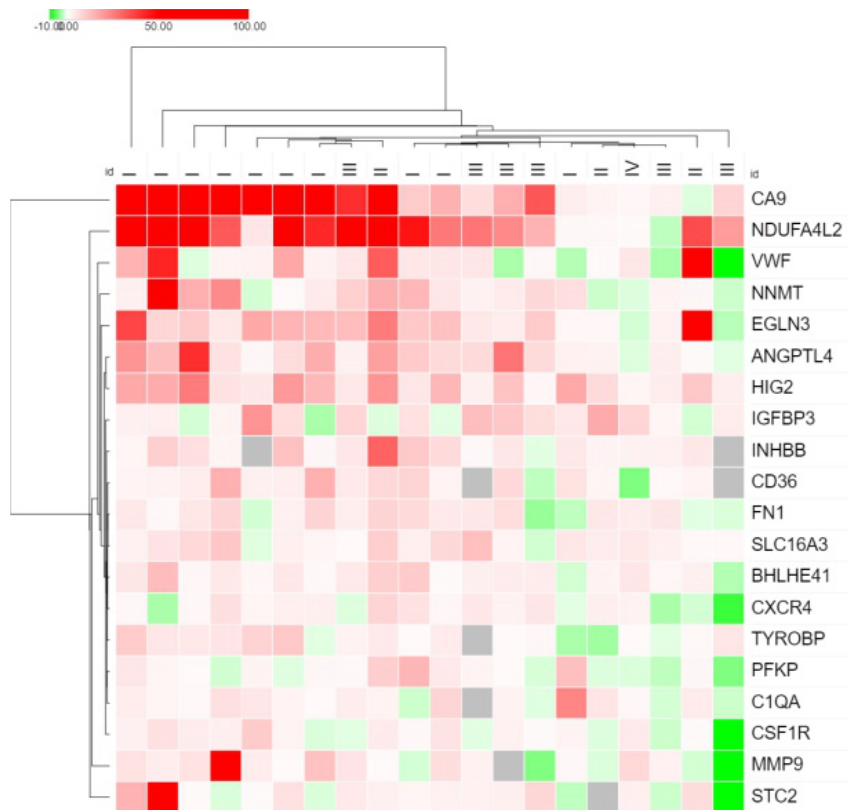
Figure 1. Heat map of the expression of 20 genes in the clear cell renal cell carcinoma (ccRCC) samples. At the top of the figure, the stages of cancer development for each sample are shown.